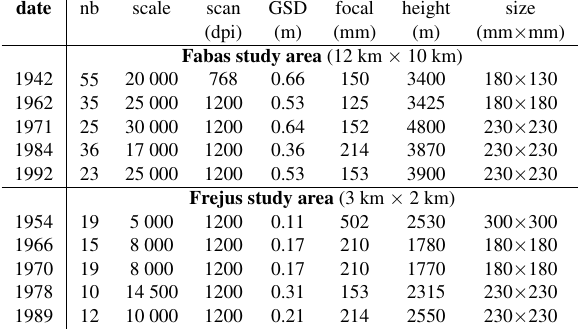
Figure 5. Frejus 1954. Examples of GCPs automatically extracted from 1954 orthoimage (left) and current orthoimage (right) .